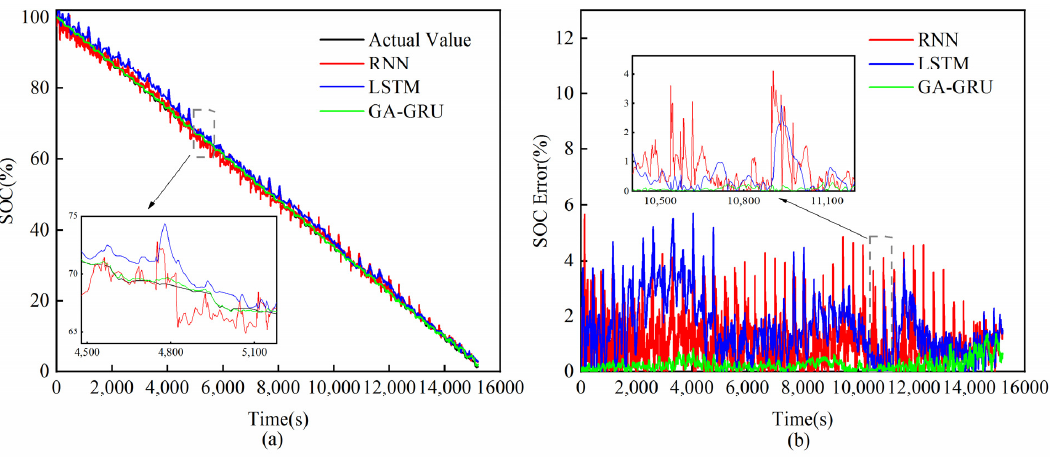
Figure 8. SOC estimation results and errors under BJDST at 20 °C. ( a ) Comparison of SOC estimation results under BJDST at 20 °C; ( b ) comparison of SOC estimation errors under BJDST at 20 °C.